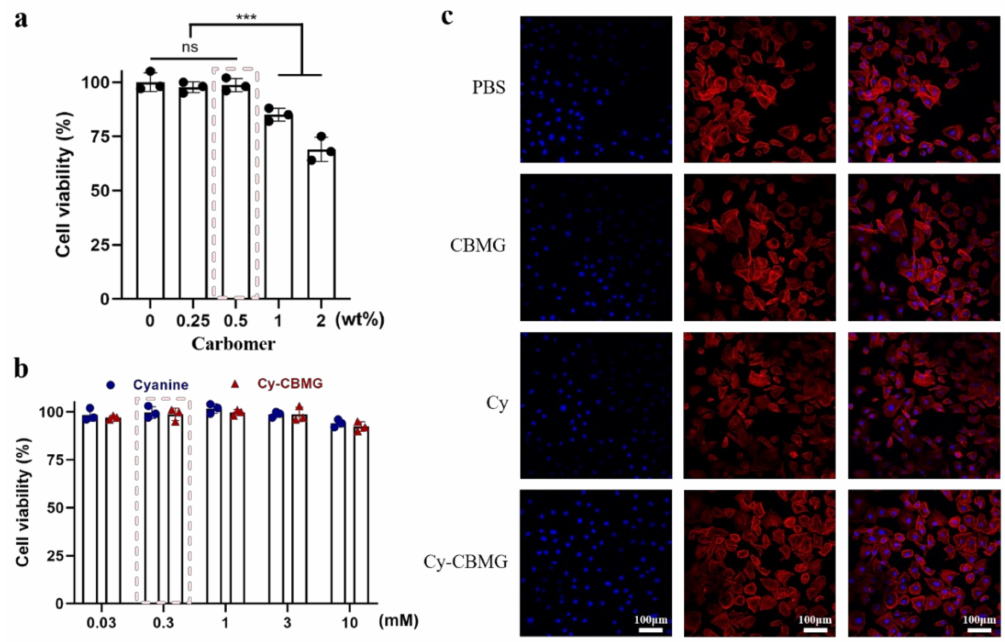
Figure 2. Biocompatibility assessment for Cy, CBMG and Cy-CBMG. ( a ) Cell viability after incubated at various concentrations of carbomer (0.25, 0.5, 1, 2 wt%). ( b ) Cell viability after incubated with various concentrations of Cy and Cy-CBMG (0.03, 0.3, 1, 3 mM). ( c ) Cytoskeleton staining of HUVECs co-incubated with PBS, CBMG (0.5 wt%), Cy (0.3 mM), and Cy-CBMG (0.3 mM). ns: no significance, p > 0.05; ***: a statistically significant difference between groups, p <